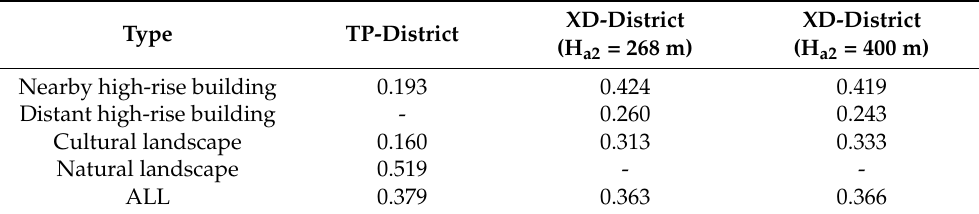
Table 4. Standard deviations of NACH values for each type of